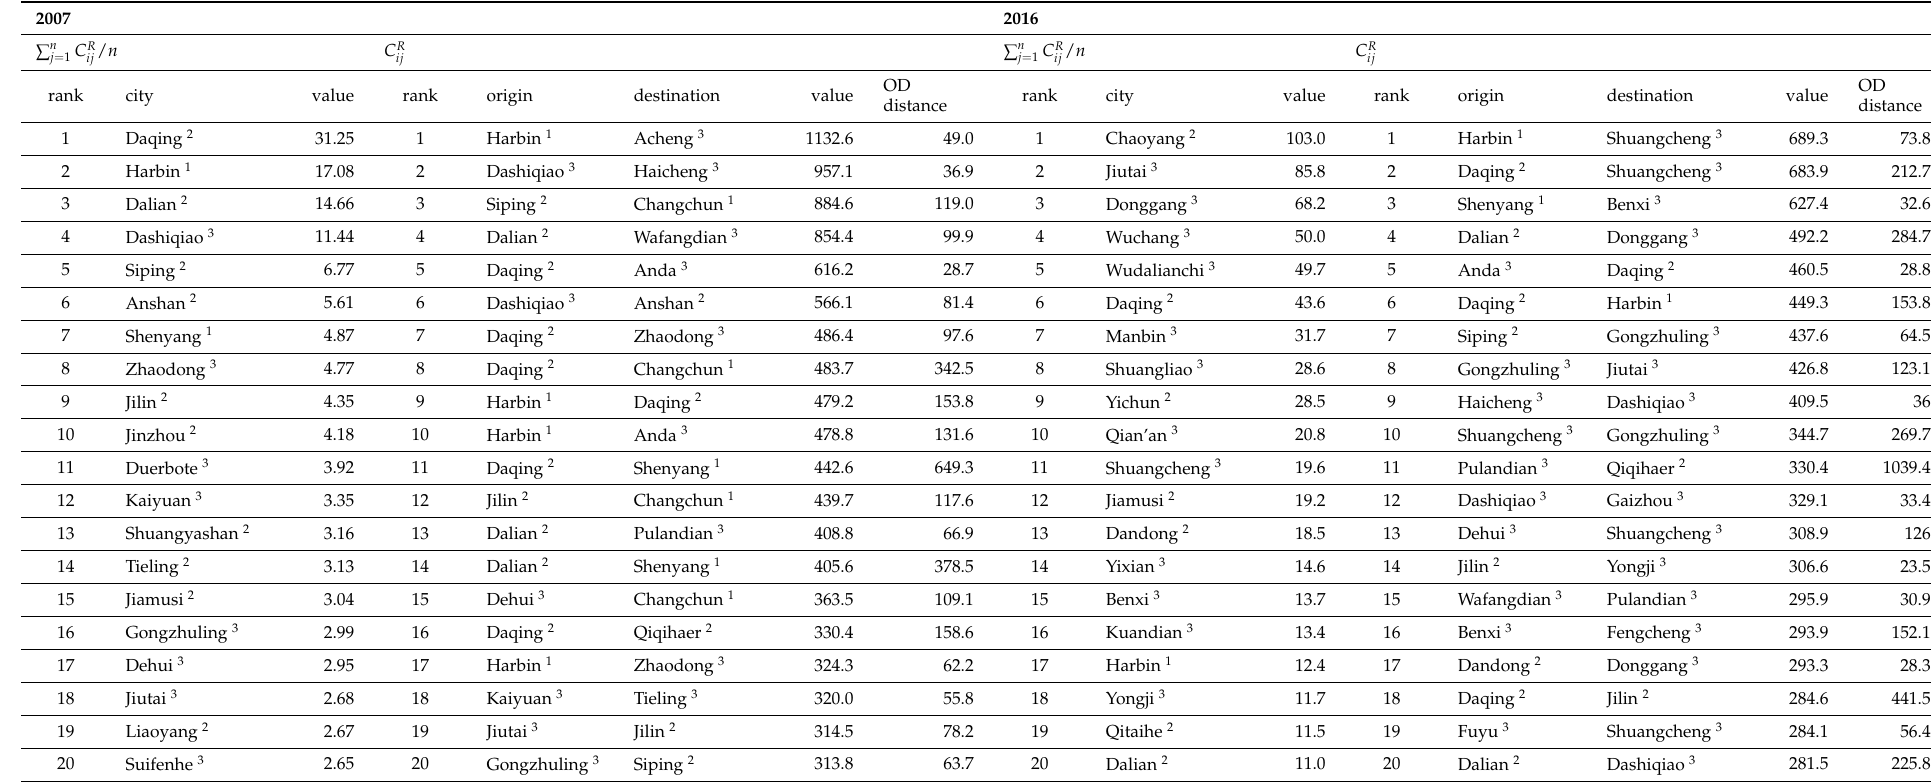
Table 2. The top 20 cities or economic linkages in 2007 and